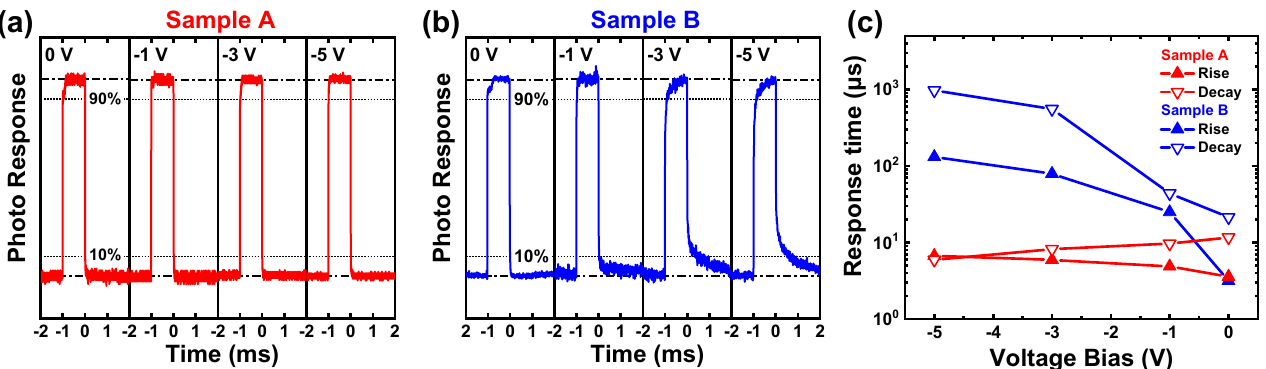
Figure 5. Time-dependent photo response curves (photovoltaic) of samples ( a ) A and ( b ) B at various reverse biases; ( c ) the rise and decay times of samples A and B at various reverse biases. The pulse frequency is 200 Hz and the duty cycle is 20%.